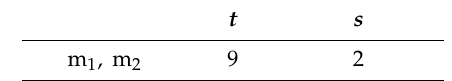
Table 2. Available and unavailable periods of machines 1 and 2 of the